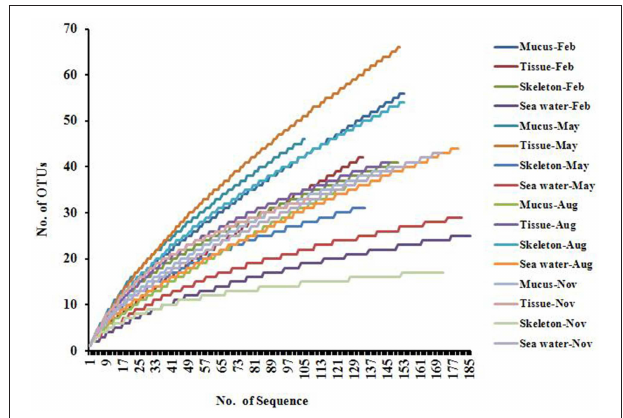
FIGURE 1 | Rarefaction curves of Actinobacteria 16S rRNA gene sequences.